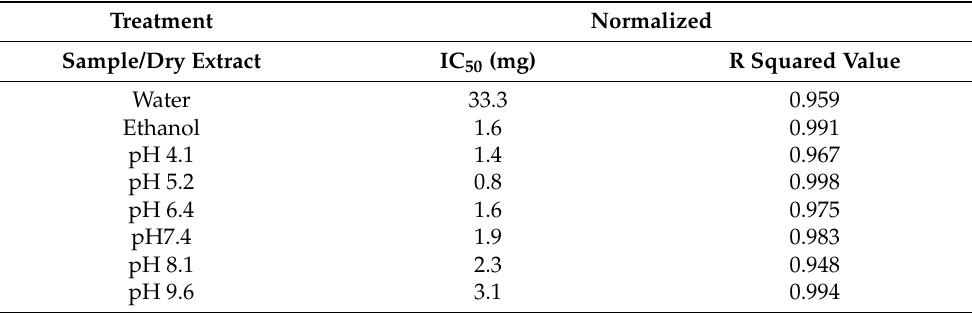
Table 1. IC 50 values of the extracts eluted at different pH conditions, all measured in milligram, and quantities of the seed extract.